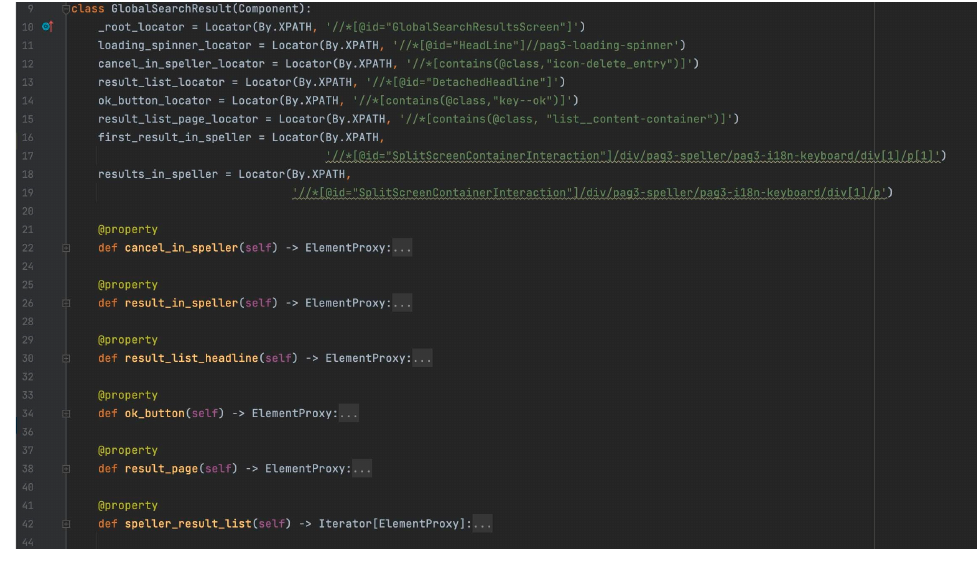
Figure 17. Example of a page class definition using LEE.